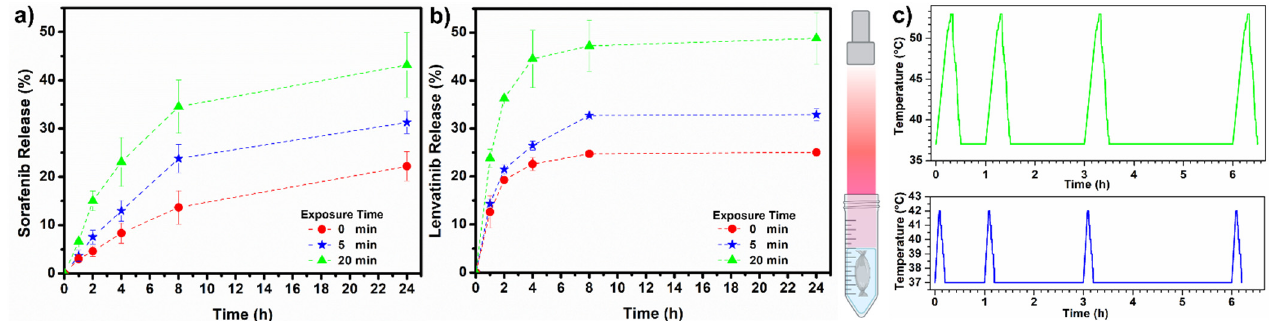
Figure 7. Drug release profiles of ( a ) SOR-NPs and ( b ) LEN-NPs without laser treatment (red) or after 5 min (blue) or 20 min (green) cycles of NIR-laser exposure. ( c ) Thermal rising and temperature decreasing during the 4 irradiation cycles performed with exposure times of 5 min (blue) and 20 min (green).